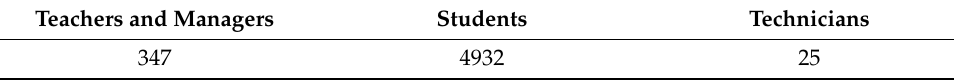
Table 1. Population sizes of the six